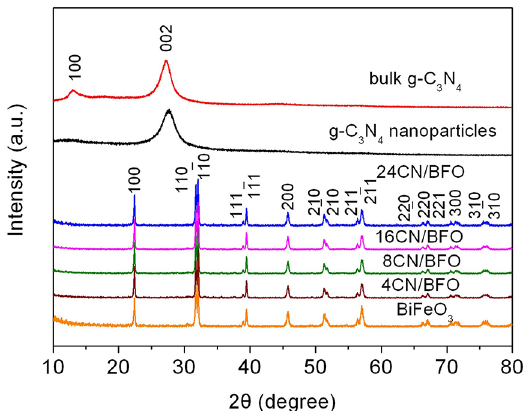
N , g-C N nanoparticles, 3 4 3 4